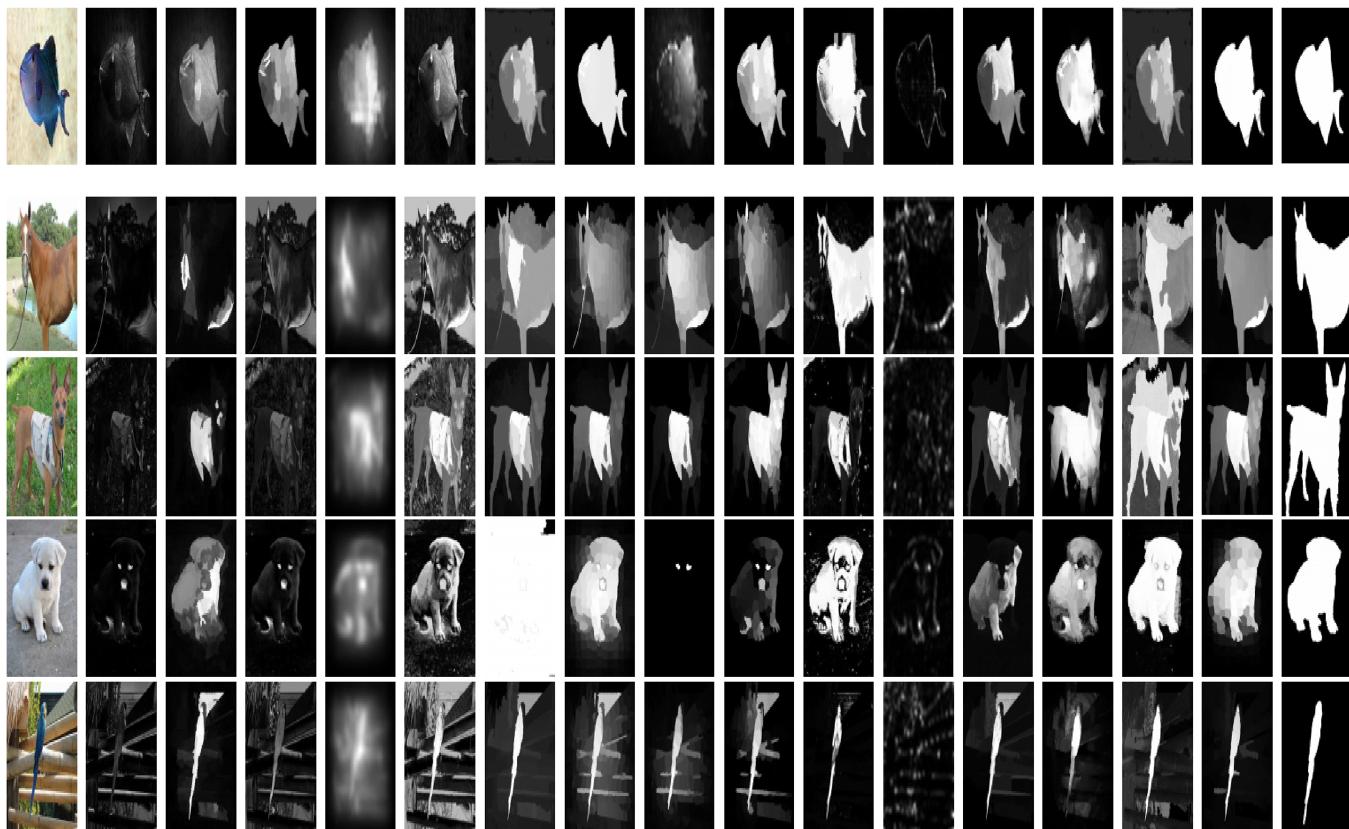
Fig 9. Comparison of proposed framework visually with the state-of-the-art methods on the MASRA dataset [38]. The SRD results are arranged as: II, AC [39], CH [44], FT [35], GB [9], HC [10], HS [36], MC [40], GM [5], RB [45], RC [10], SR [43], UF [41], DS [6], LC [42], SRD results of our model, and GT.